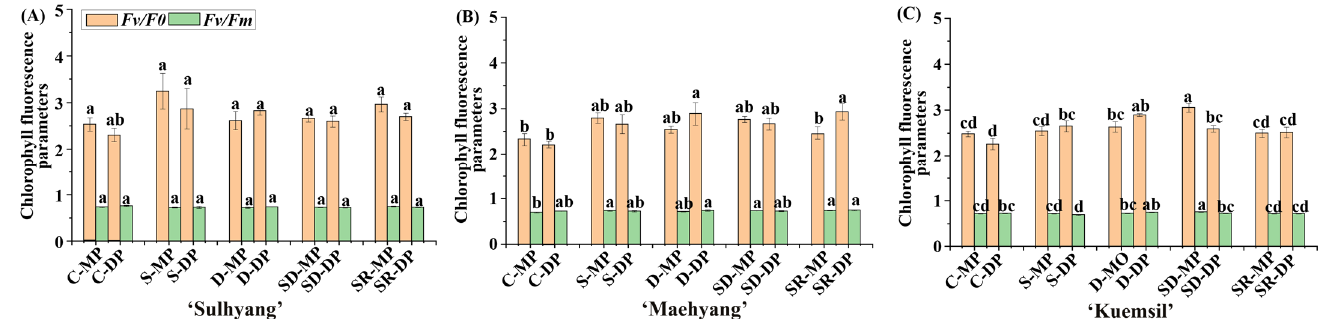
Figure 4. The chlorophyll fluorescence parameters Fv/Fm and Fv/F0 of strawberry ( A ) ‘Sulhyang’; ( B ) ‘Maehyang’; and ( C ) ‘Kuemsil’ as affected by the Si treatments. Lowercase letters indicate significant differences calculated by the Duncan’s multiple range test at p ≤ 0.05: C, control; S, sprayed “mother” plant; D, drenched “mother” plant; SD, dressed “mother” plant; SR, sprayed “daughter” plant; MP, “mother” plant; and DP, “daughter” plant.